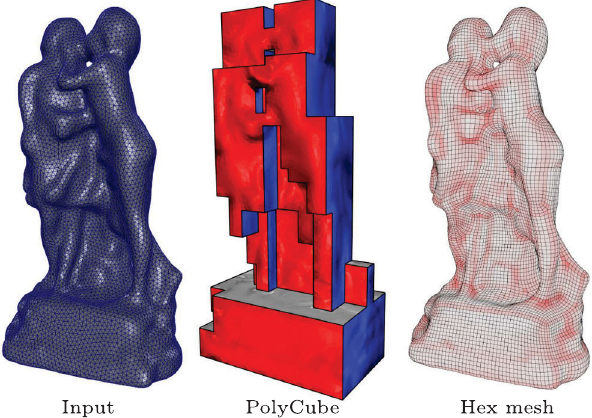
Fig. 9 PolyCubes for all-hex remeshing. It contains three steps: (1) constructing a PolyCube, (2) performing hex mesh generation of the PolyCube domain, and (3) mapping the hex mesh back to the input